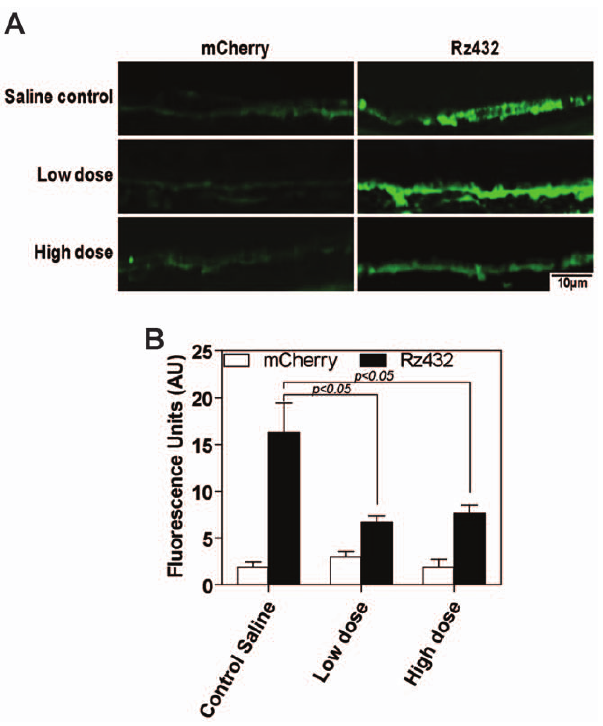
Figure 7. 8-OH DPAT decreases oxidative stress in the RPE of SOD2 knockdown eyes of mice. Eyes received injection of AAV- SOD2 ribozyme or AAV-mCherry and animals received subcutaneous 8- OH DPAT or saline control for up to 4 months. Sections were stained for 8-hydroxydeoxyguanosine (8OHdG) (green). A – Representative sec- tions of 8OHdG expression in the RPE of control and SOD2 eyes receiving different concentrations of 8-OH DPAT. B - Graph shows quantitation of 8OHdG fluorescence in the RPE layer.